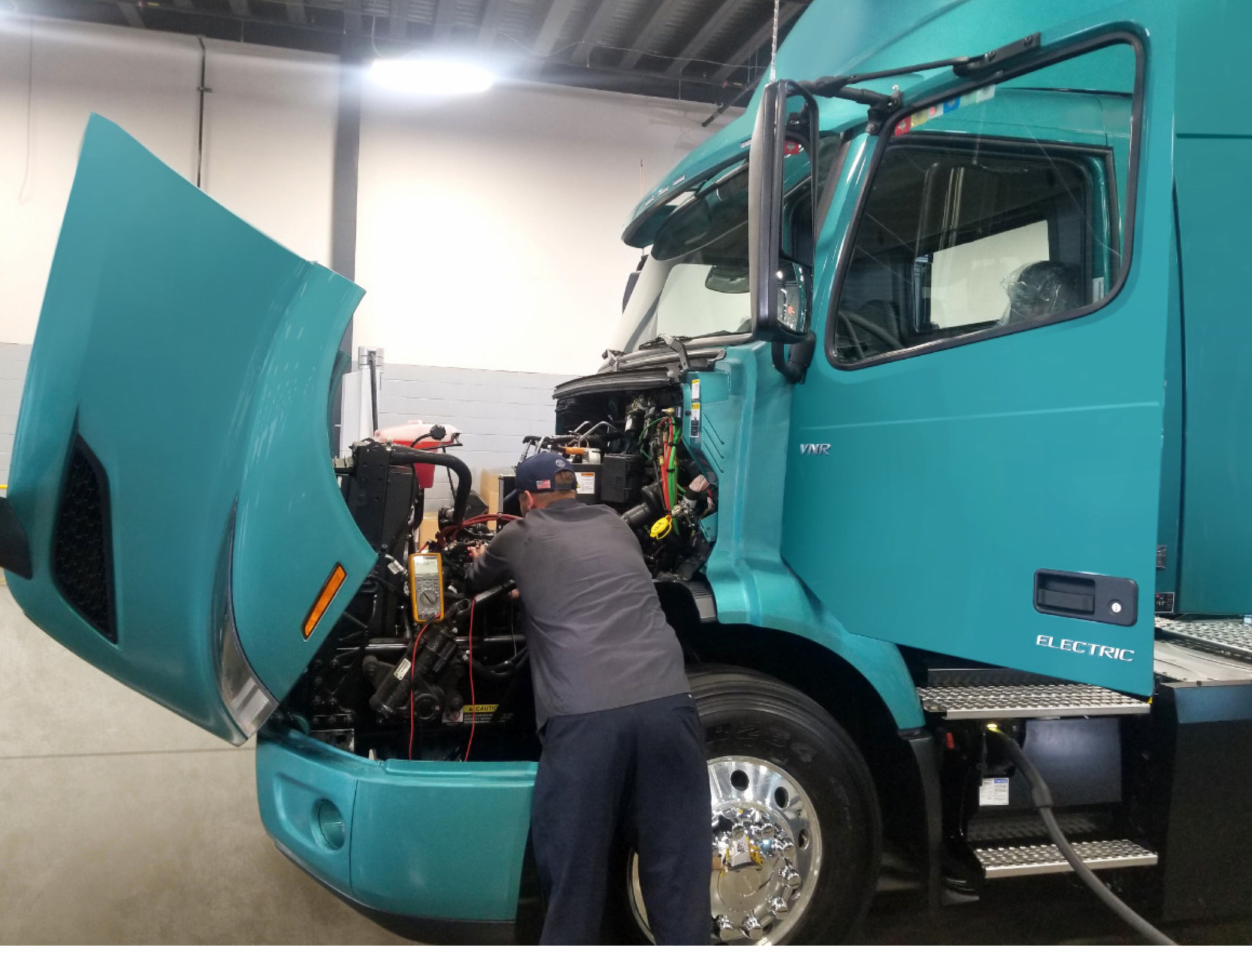
Figure 7. A specially certified technician at a Volvo Trucks dealership performs maintenance on a Volvo VNR